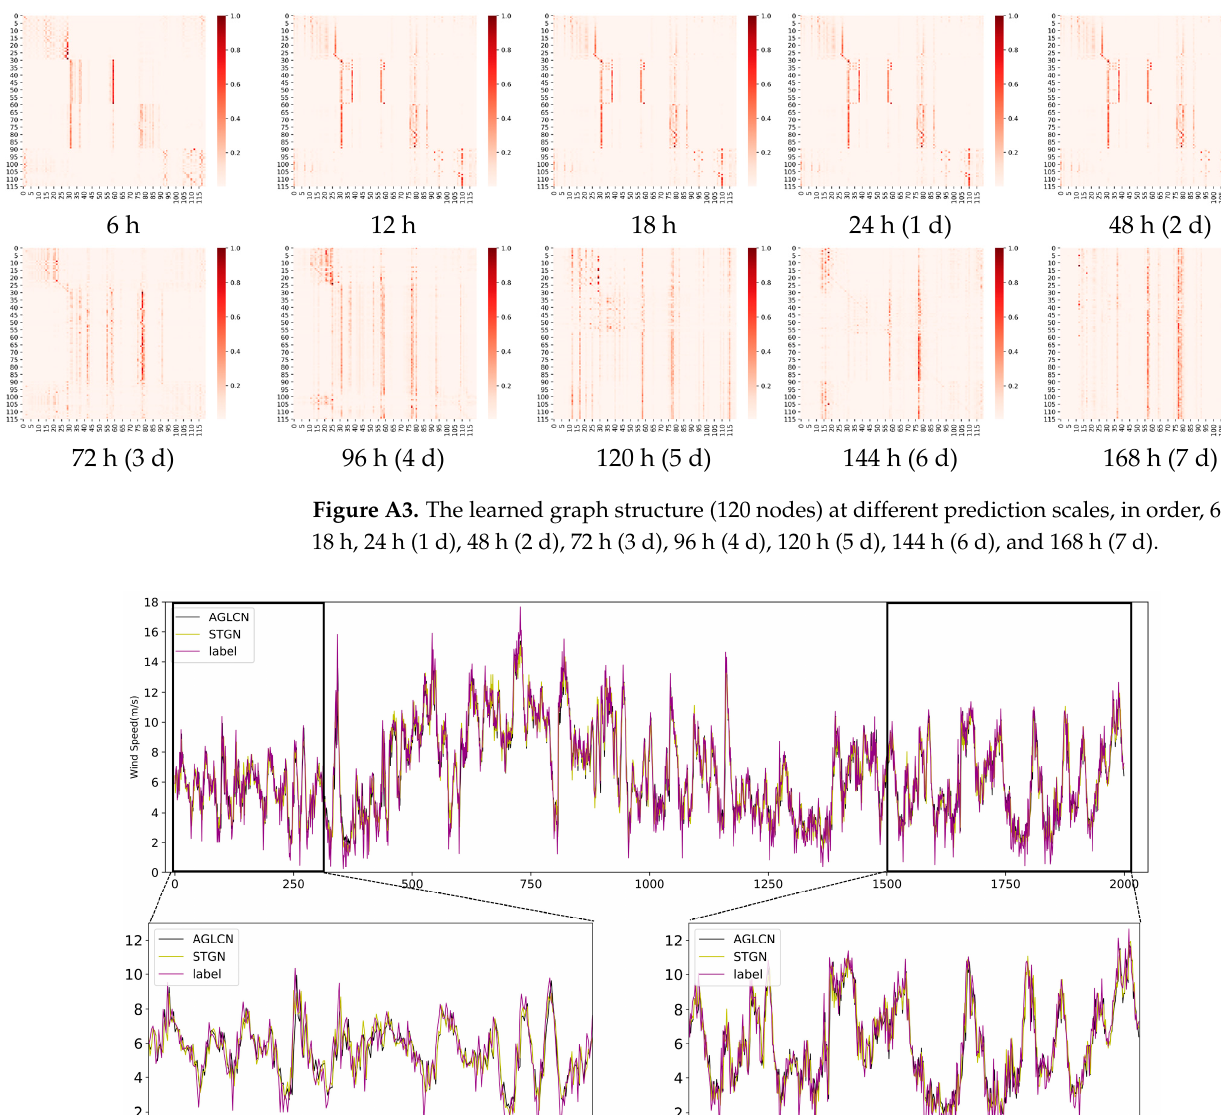
Figure A2. The learned graph structure (40 nodes) at di ff erent prediction scales, in order, 6 h, 12 h,